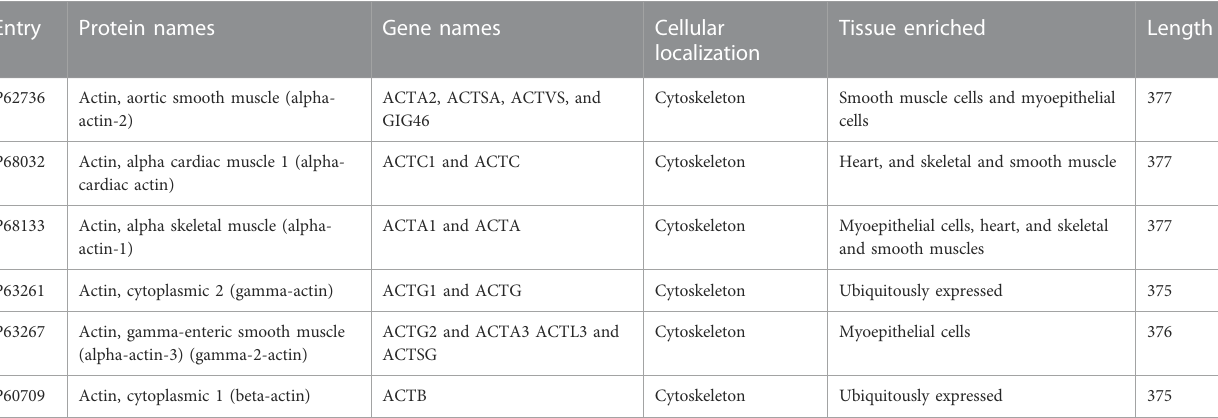
TABLE 1 List of actins used in the study.